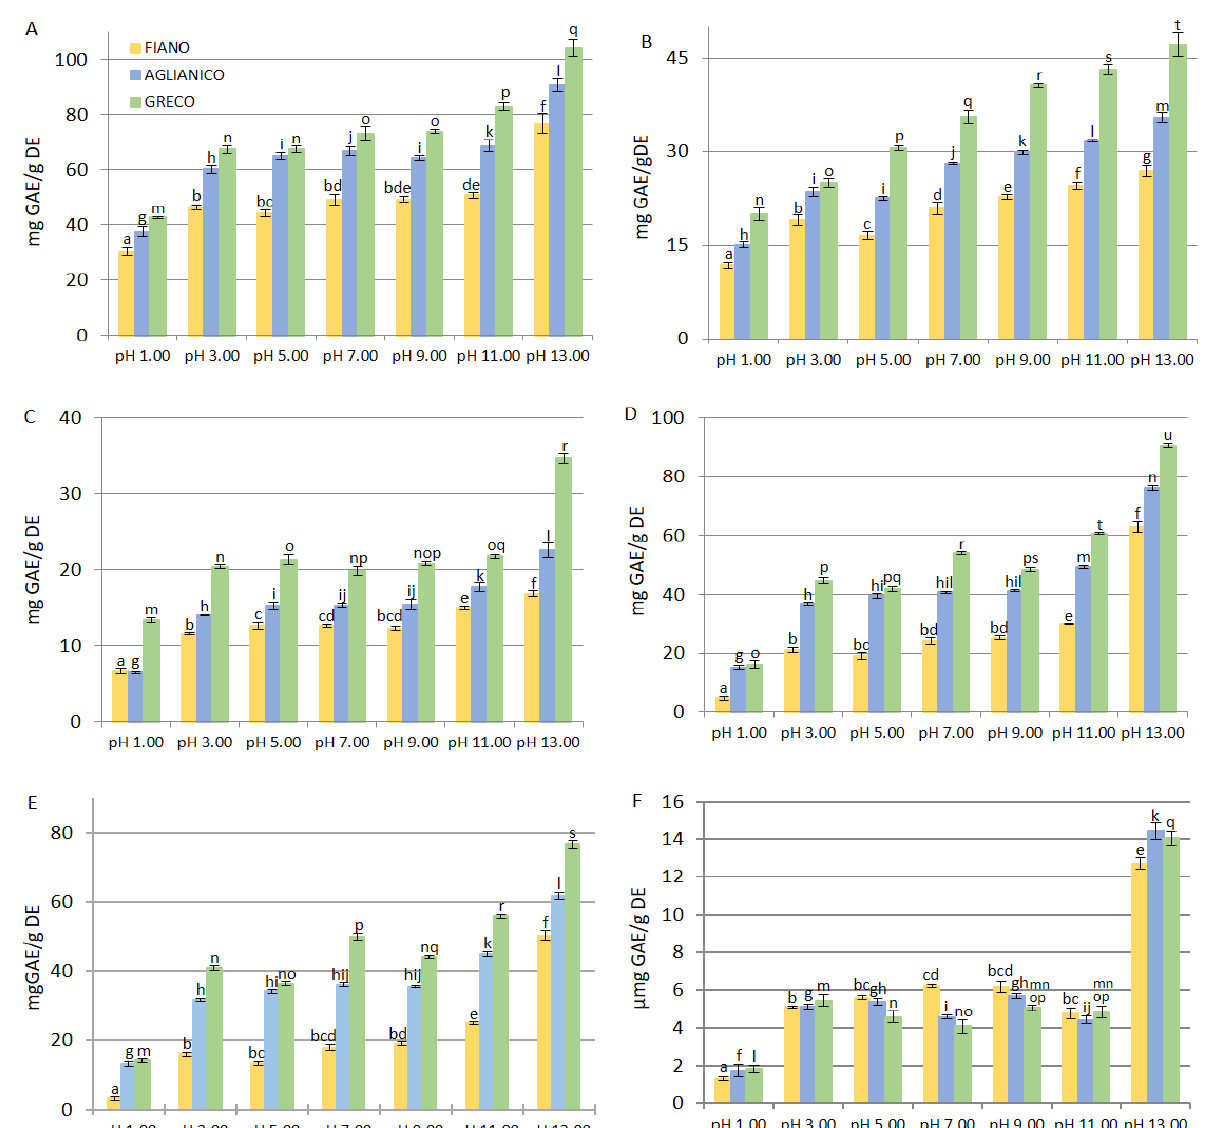
Figure 1. Total phenols ( A ), ortho -diphenols ( B ), flavonoids ( C ), total tannins ( D ), condensed tannins ( E ), and hydrolysable tannins ( F ) in grape cane extracts from Vitis vinifera cultivars “Aglianico, “Fiano” and “Greco”. All determinations were performed in triplicate and results were expressed as mean ± SD. Bars with different letters denote significant differences at p < 0.05. ( A : a-f, g-l, m-q; B : a-g, h-m, n-t; C : a-f, g-l, m-r; D : a-f, g-n, o-u; E : a-f, g-l, m-s; F : a-e, f-k, l-q).